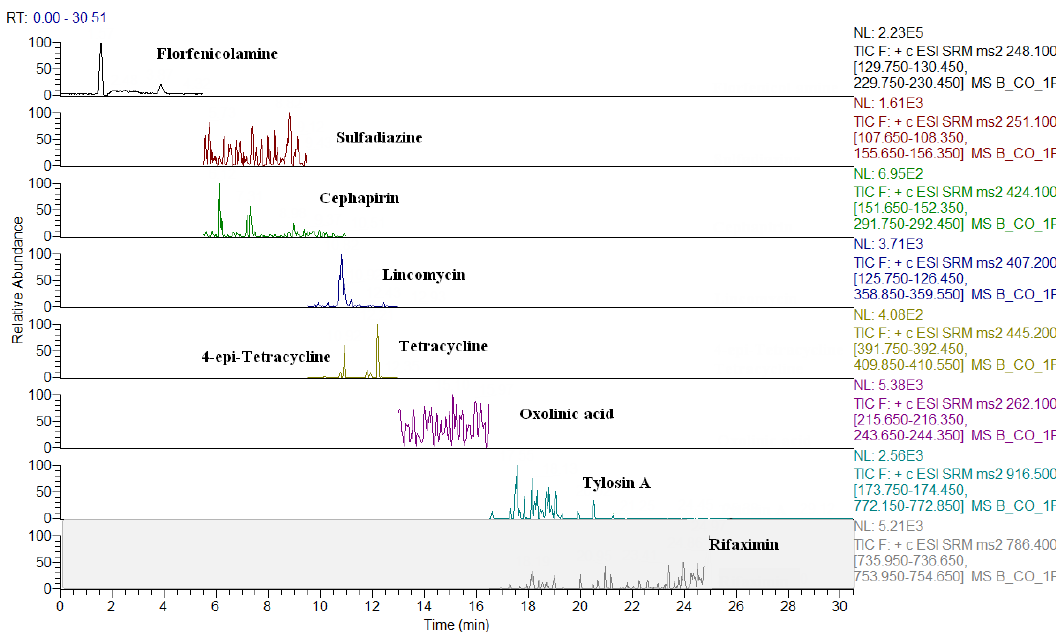
Figure 3. LC-QqQ chromatograms of a blank bovine milk.